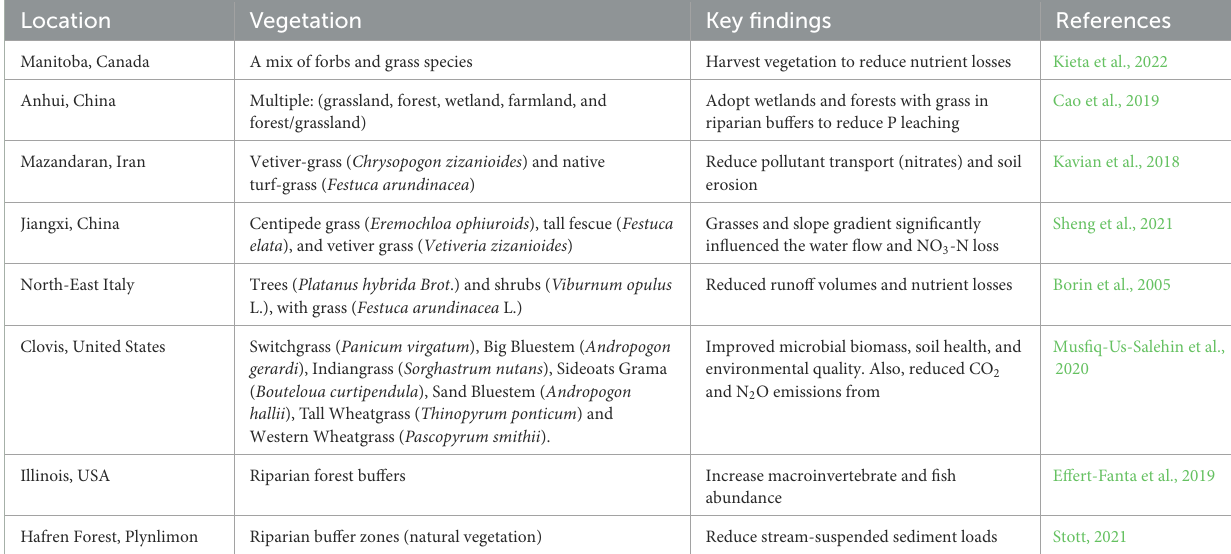
TABLE 1 Worldwide use of riparian buffer use and key